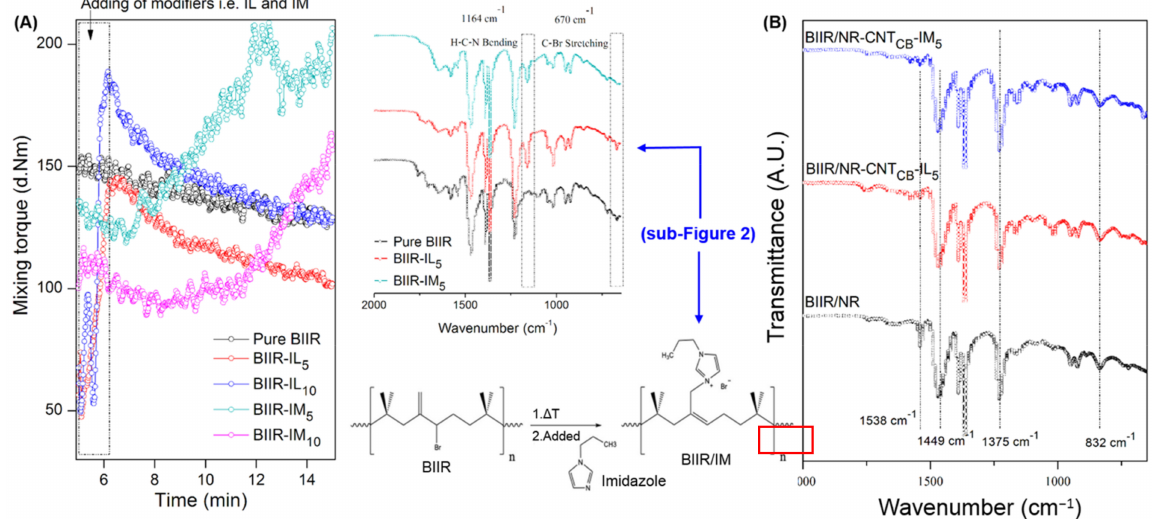
Figure 2. Mixing torque of pure BIIR and modified-BIIR with IL and IM compound ( A ), the ATR-FTIR images and their proposed reaction (sub-Figure 2), and the spectra of the composites with 5 phr of IL and IM ( B